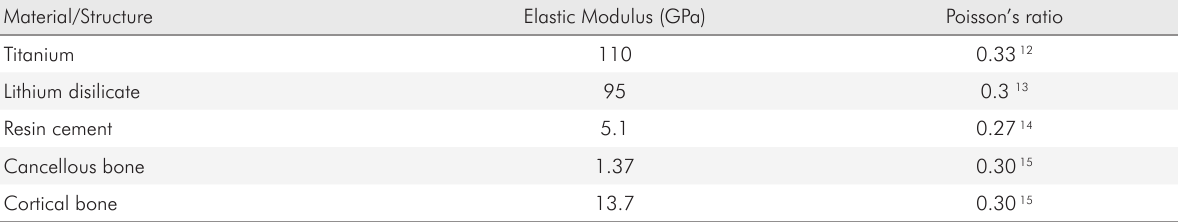
Table. Distribution of mechanical properties of the materials used in FEA